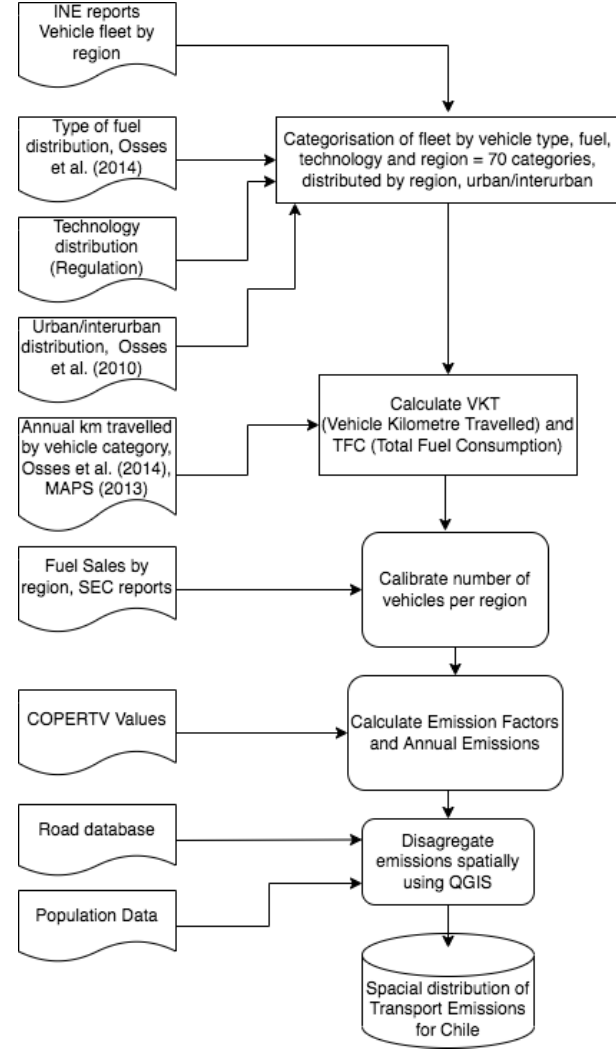
Figure 1. Methodological